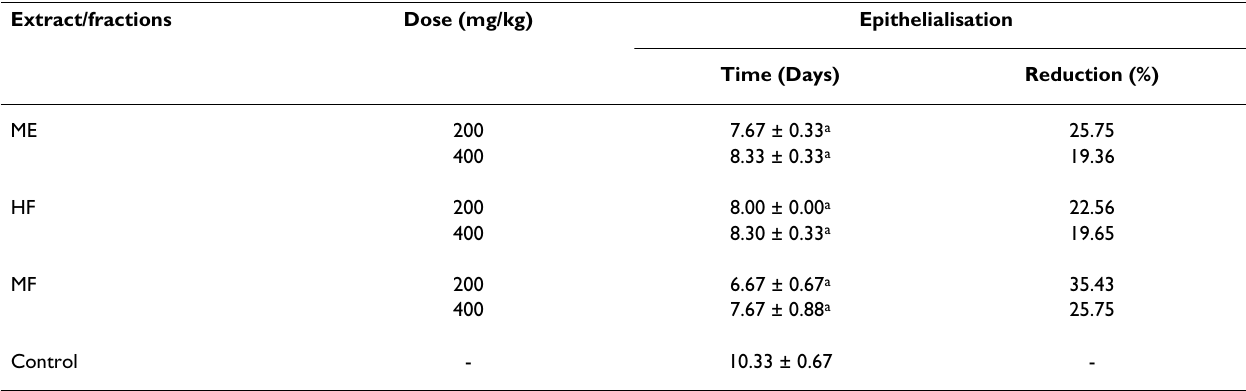
Table 5: Effect of extract and fractions on epithelialisation time in rats